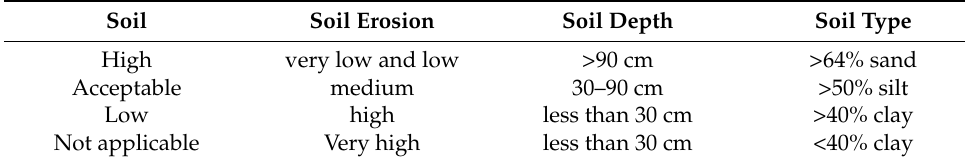
Table 1. Soil erosion, depth, and type according to their suitability in